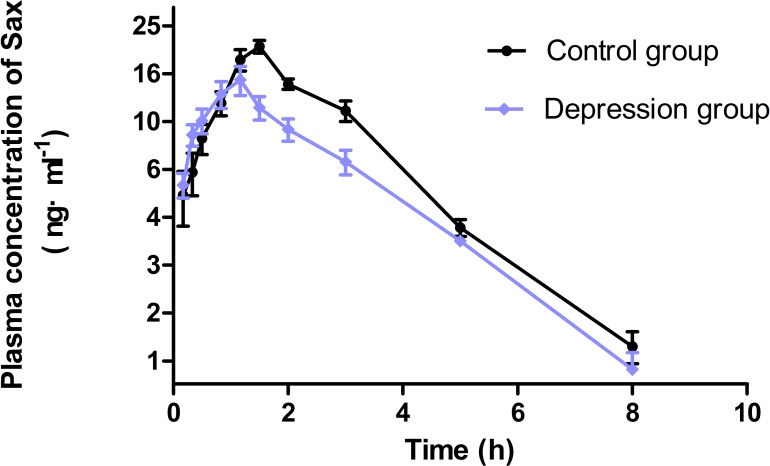
The concentration-time curve of Sax in plasma after oral 0.5 mg/kg (n = 9, mean ± SD).The area under curve in the depression group significantly decreased compared with the control group (67.06 → 44.63 ng/mL h). The first four concentrations exceeded than the control group. The depression group reached the peak time in advance (1.46 → 1.04 h), but the peak concentration lowered levels than the control group (20.48 → 14.85 ng/mL).